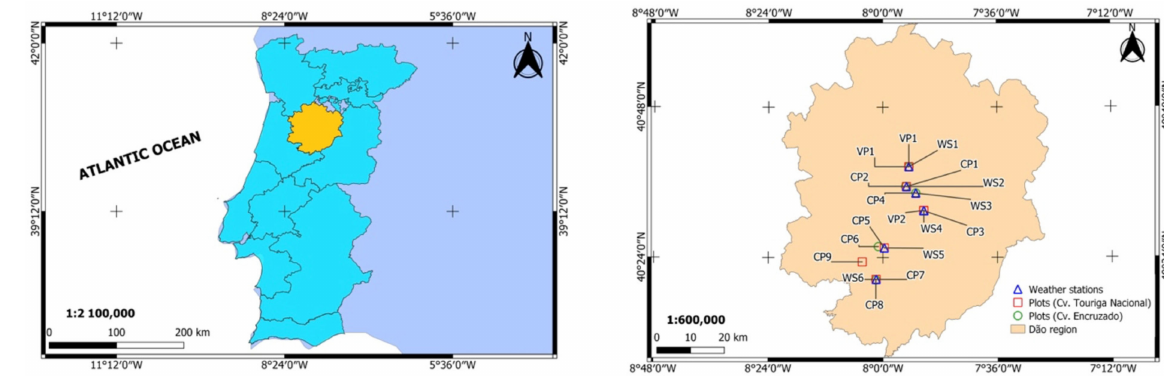
Figure 1. Map of mainland Portugal with the D ã o Wine Region and TN vineyard plot (red square), EN vineyard plot (Green circle), and weather station locations (blue